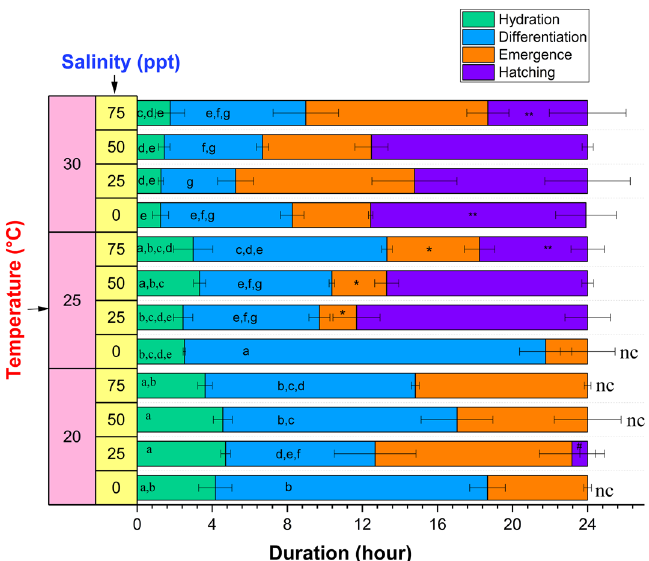
Figure 3. Duration of different stages of hatching at different water salinities and temperature. Values are expressed as mean ± standard deviation (n = 3). In each category (hydration, and differentiation stage duration), means that do not share the same letter are significantly different from each other (two-way ANOVA with Bonferroni post-hoc test, p < 0.05). The hatching stages which were not complete within 24 h were not statistically analyzed and marked with “nc”. * and # denote significantly different emergence and hatching stage duration, respectively, at a temperature as compared to the other tested temperatures (one-way ANOVA with Bonferroni post-hoc test, p < 0.05). ** denotes significantly different hatching stage duration between two different tested salinities (one-way ANOVA with Bonferroni post-hoc test, p <